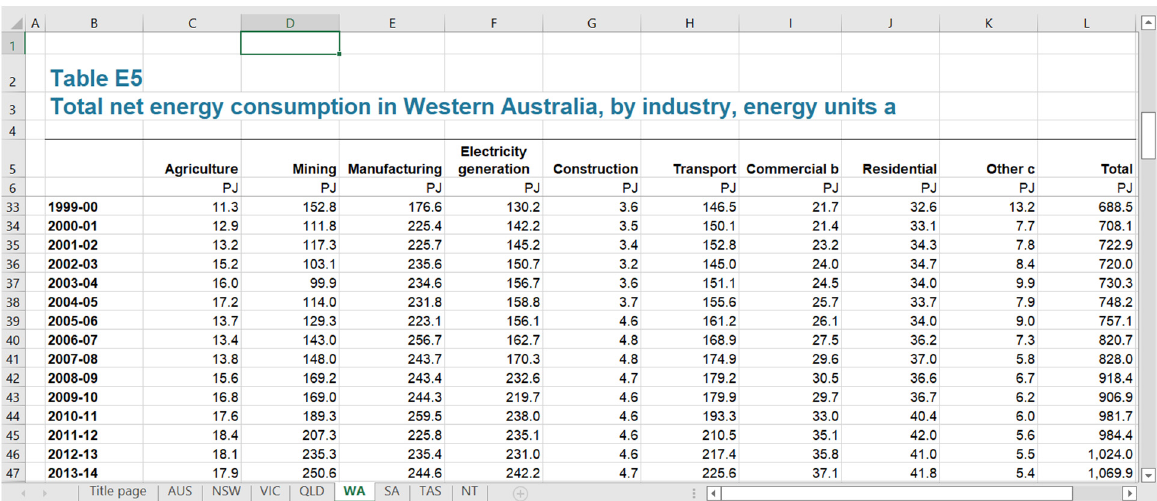
Figure 8. Screenshot of the Australian energy consumption data in Microsoft Excel.